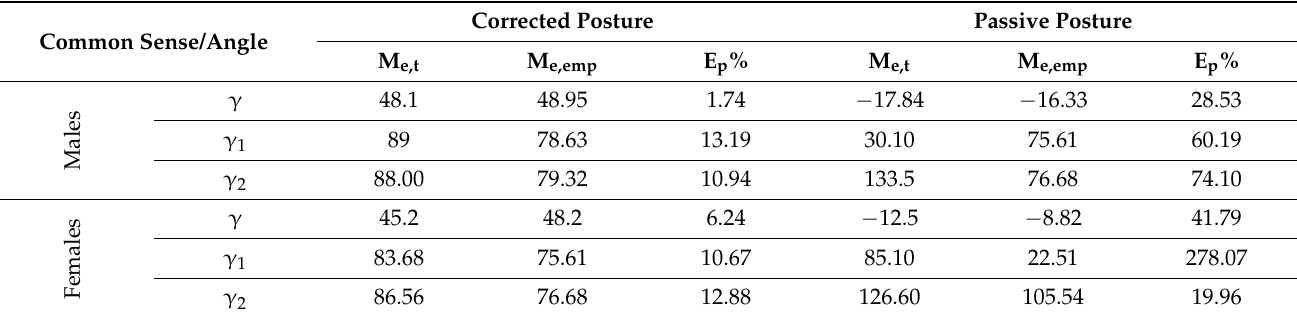
Table 2. Difference between the corrected and passive